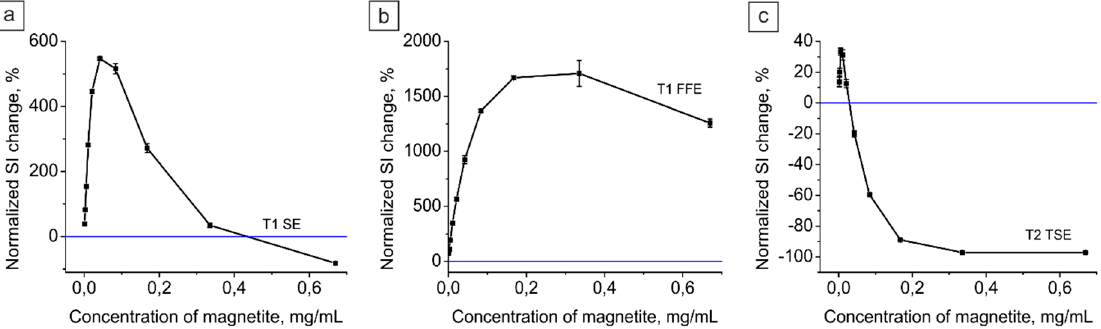
Figure 7. MRI contrast dependence on magnetite colloid concentration: ( a ) T 1 spin-echo and ( b ) T 1 gradient echo; ( c ) T 2 turbo spin-echo. The blue line on each graph–water contrast level.